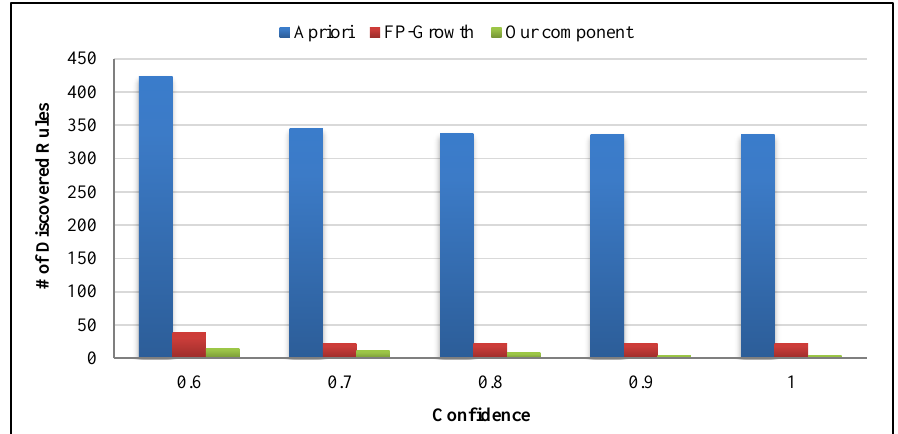
Figure 10. Rule number comparison for Weather data source